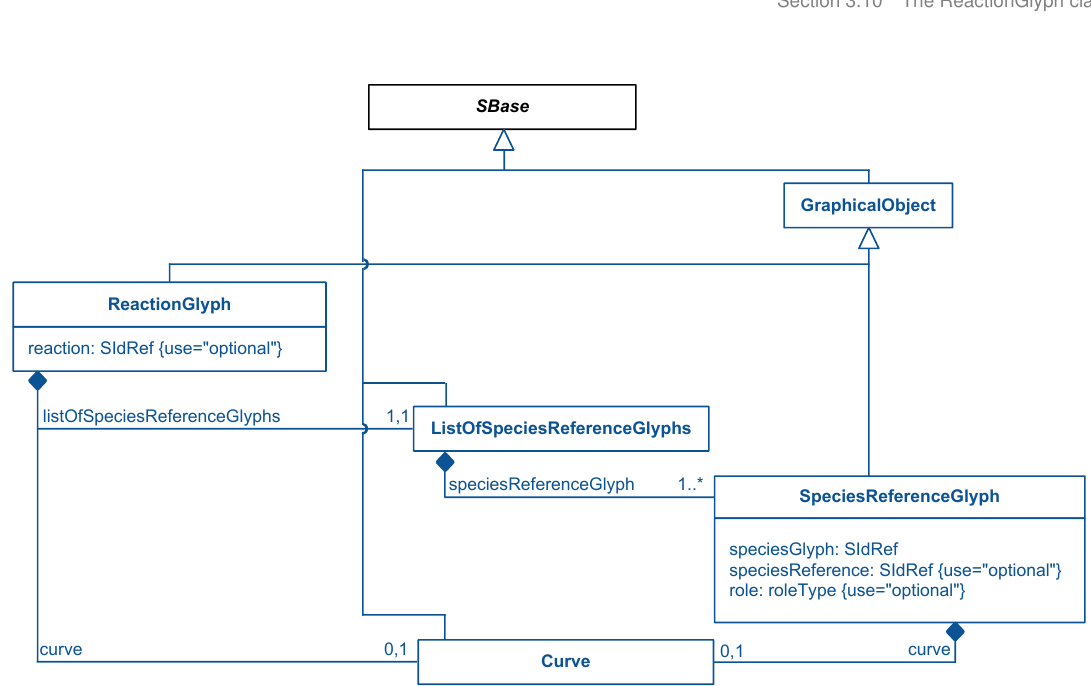
Figure 12: The definitions of the ReactionGlyph